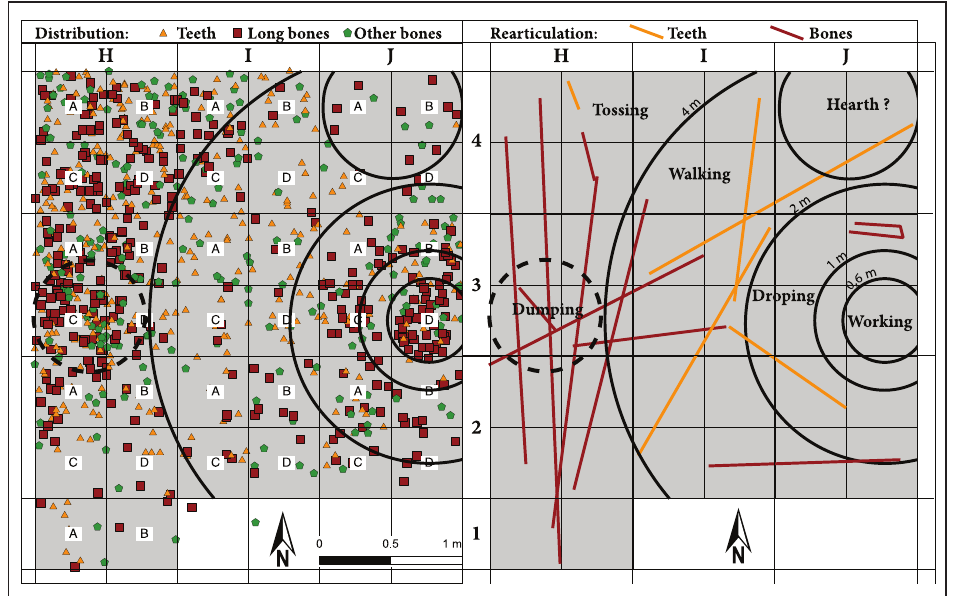
Figure 7: There exists a spatial sorting of the bone types: long bones fragments cluster in two areas as opposed to smaller bones (short or irregular) and teeth. The spatial interpretation of activity zones inside the LCM camp in El Mirón cave refers to bone working, dropping, walking, tossing and dumping zones. A hearth was presumably located around square J4. A bone processing area around square J3 appears to have played a central role in the organ- ization of reconstructed